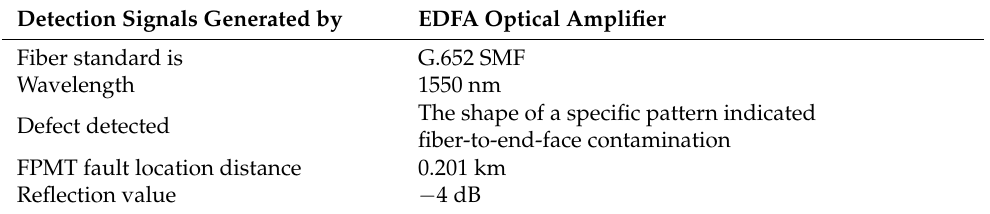
Figure 8. The improving FPMT circuit detected a fiber end-face contamination pattern shape at event 2. Table 6. The parameters and practical results detected at event